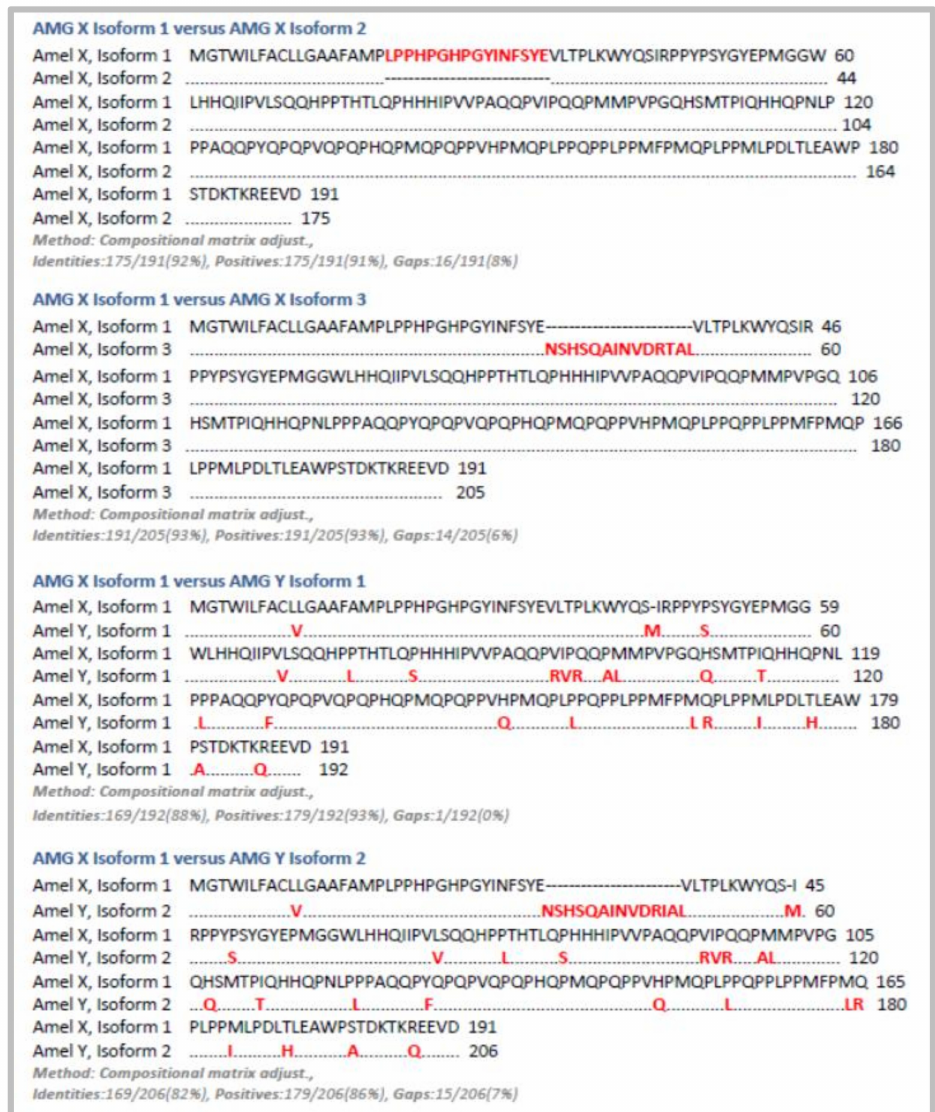
Figure 2. BLAST pairwise with dots for identities between Amelogenin x isoform 1 and the other four